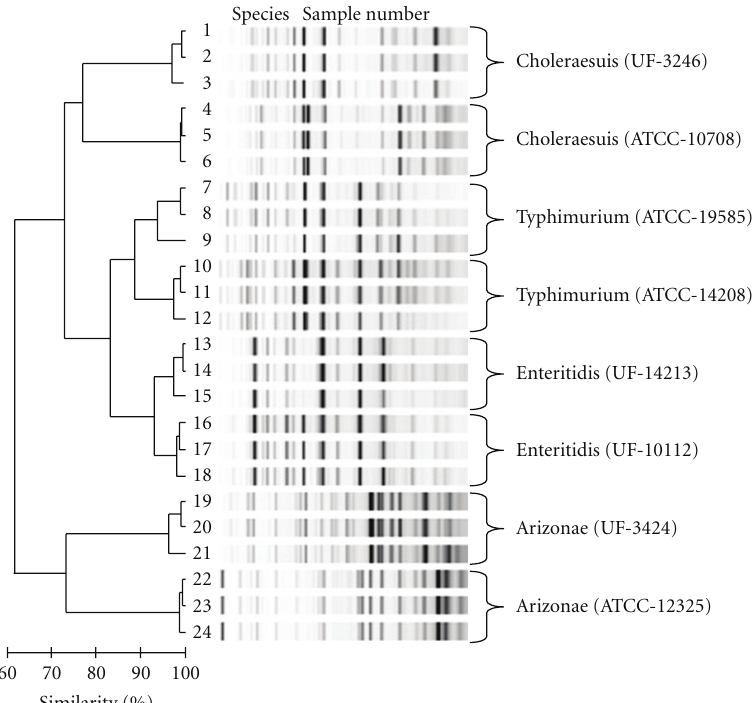
Figure 2: DiversiLab rep-PCR dendrogram. Representative strains are shown to demonstrate the segregation of di ff erent serotypes by rep- PCR. Cluster A was comprised of duplicate serovars of subspecies I (Typhimurium, Choleraesuis, and Enteritidis), while cluster B included duplicate serovars of subspecies III (Arizonae). Within each individual serovar, analyzed in triplicates, > 94% DNA similarity was observed. More than 70% DNA relatedness was noted between serovars of the same serovars. The scale at the bottom indicates the percentage similarity among fingerprints of each